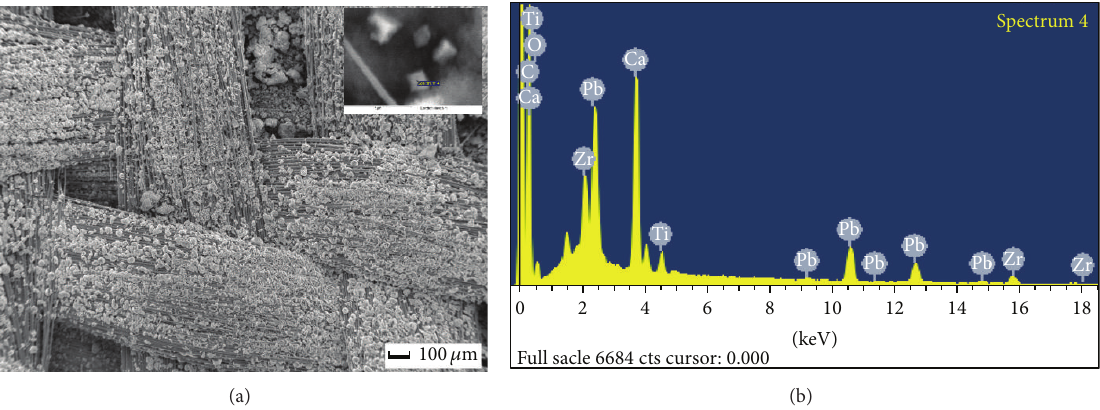
Figure 1: SEM morphology and energy dispersive X-Ray spectrum of the PZT/glass fabric piezoelectric composite (a) morphology of composite; (b) energy dispersive X-Ray spectrum.